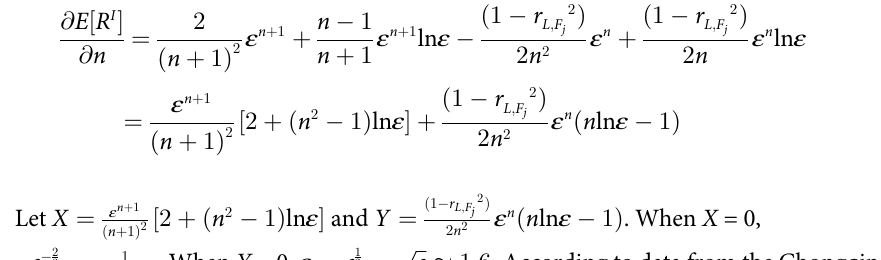
ffiffi p � 1 : 6 . According to data from the e